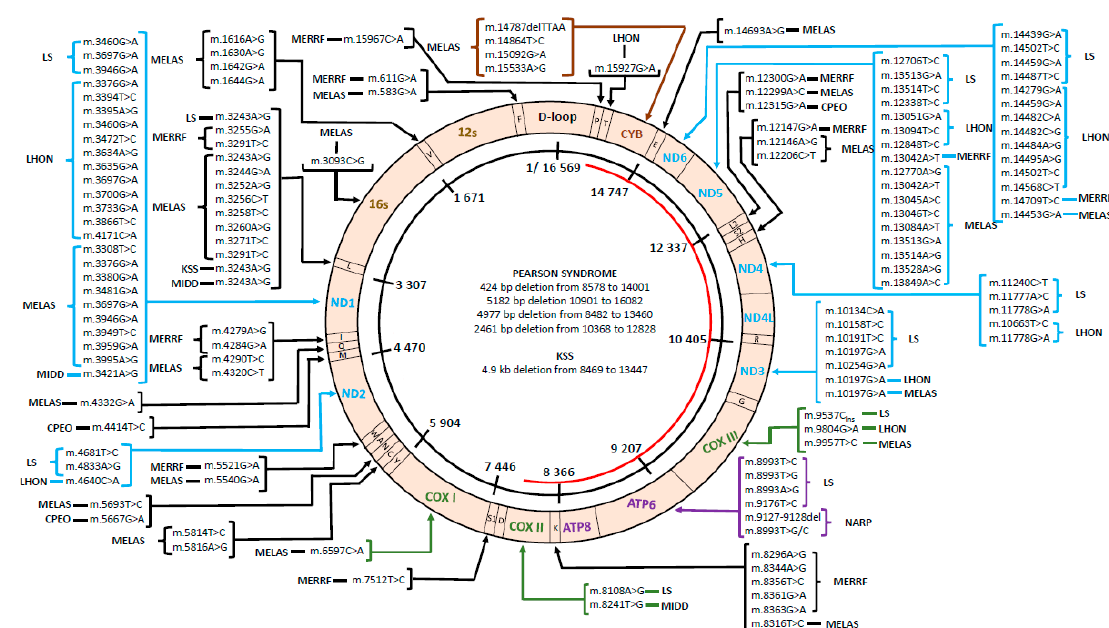
Figure 1. Mitochondrial DNA (mtDNA) mutations reported in different types of diseases. Mitochondrial genome diagram and common mutations reported in human diseases. Mutations are depicted by locations of mutated base, and the single large-scale deletions are shown in the center of the genome. (C: cytosine, G: guanine, T: thymine, A: adenine, ins: insertion, del: deletion). The D-loop, a